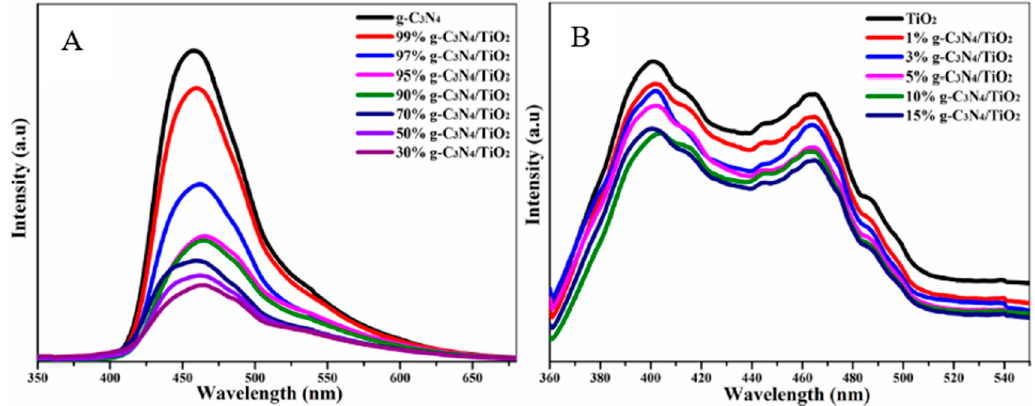
Figure 5. Photoluminescence spectroscopy emission spectra of g-C 3 N 4 , TiO 2 , and g-C 3 N 4 /TiO 2 composites under an excitation wavelength of 310 nm. Reprinted from reference [74]. Copyright 2020 ACS.